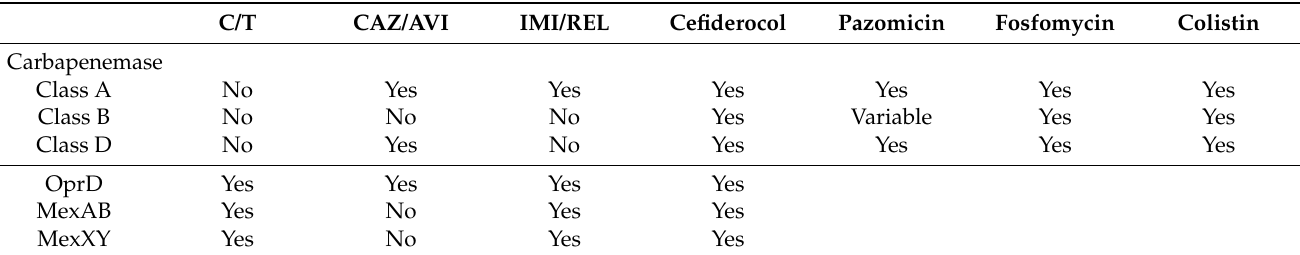
Table 1. Treatment options for Carbapenem-resistant P. aeruginosa according to mechanism of resis- tance [67–71] C/T, Ceftolozane-Tazobactam; CAZ/AVI, Ceftazidime-avibactam; IMI/REL, Imipenem-